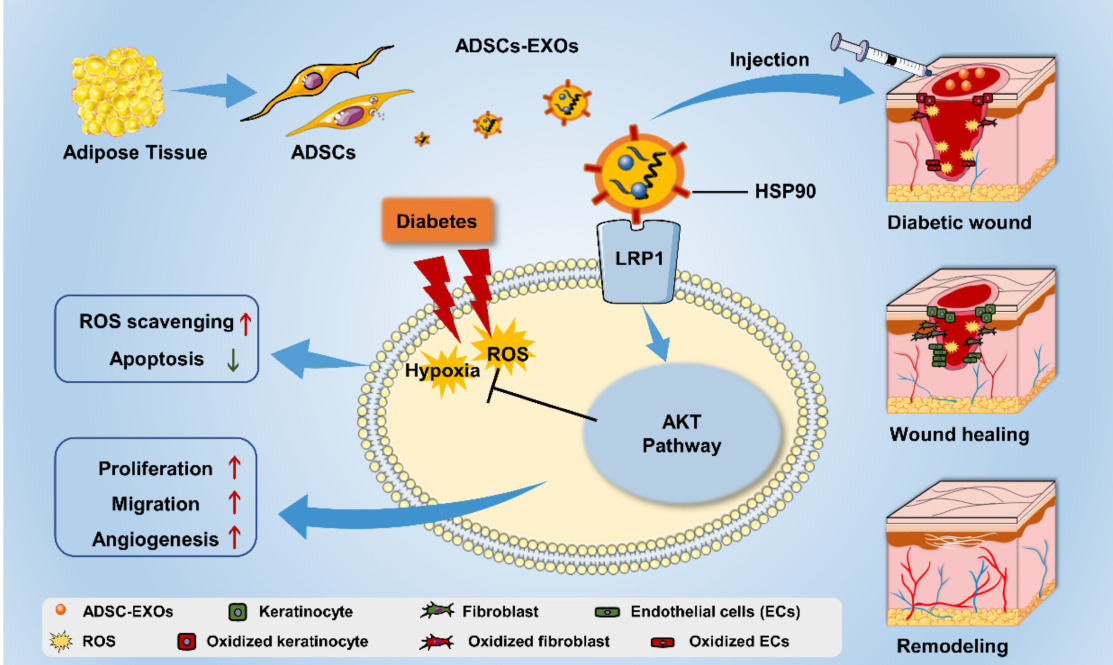
Figure 8. The mechanism of ADSC-EXO modulating diabetic wound-healing process. Wound healing is a complex and well-orchestrated biological process; it is commonly divided into four overlapping and sequential phases (hemostasis, inflammation,